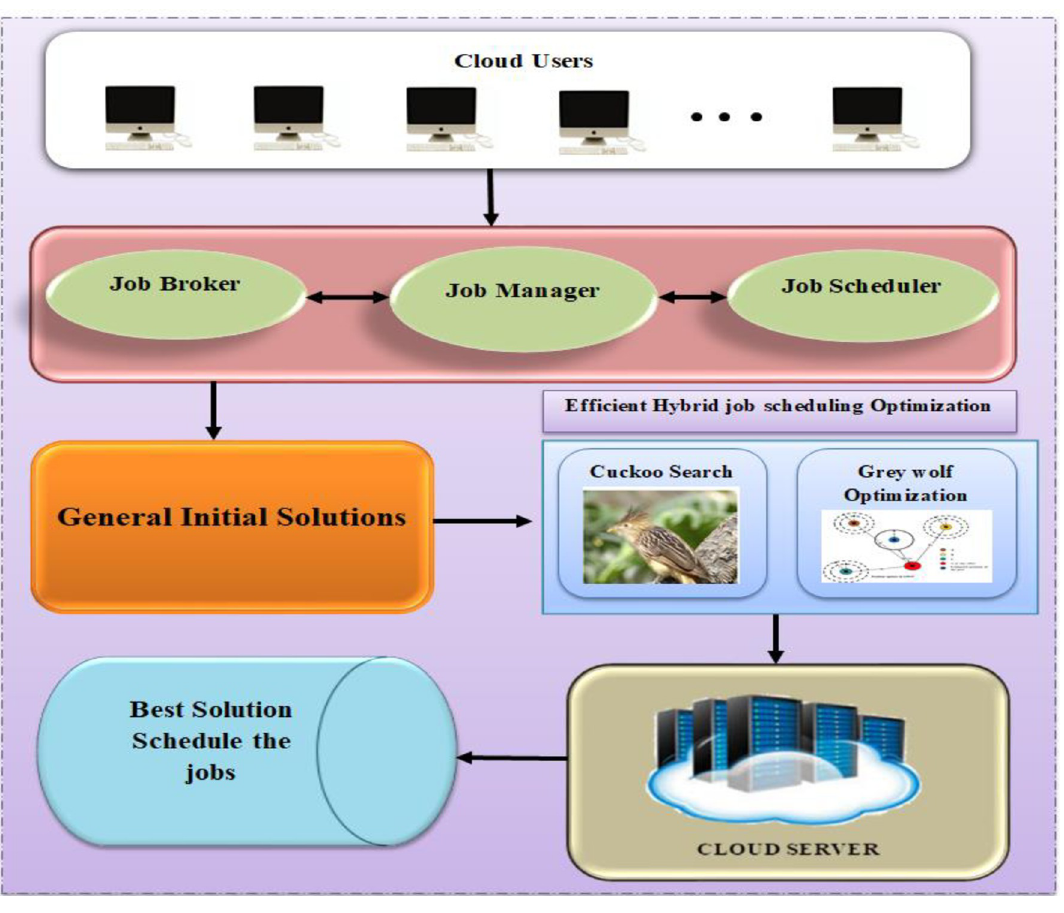
Fig 2. Proposed diagram of EHJSO method.